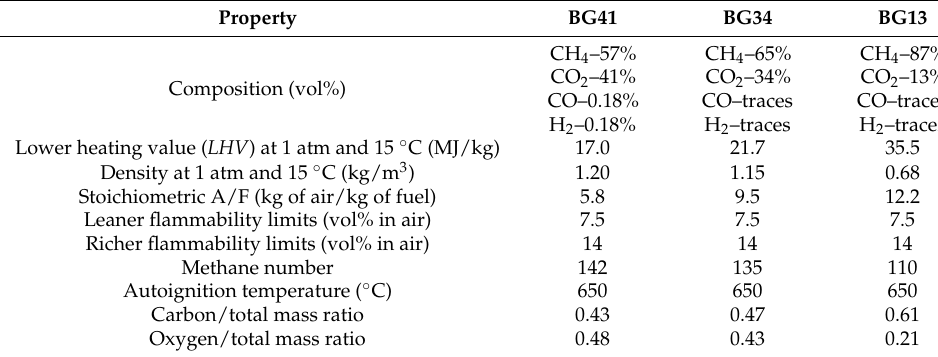
Table 1. Biogas properties at different